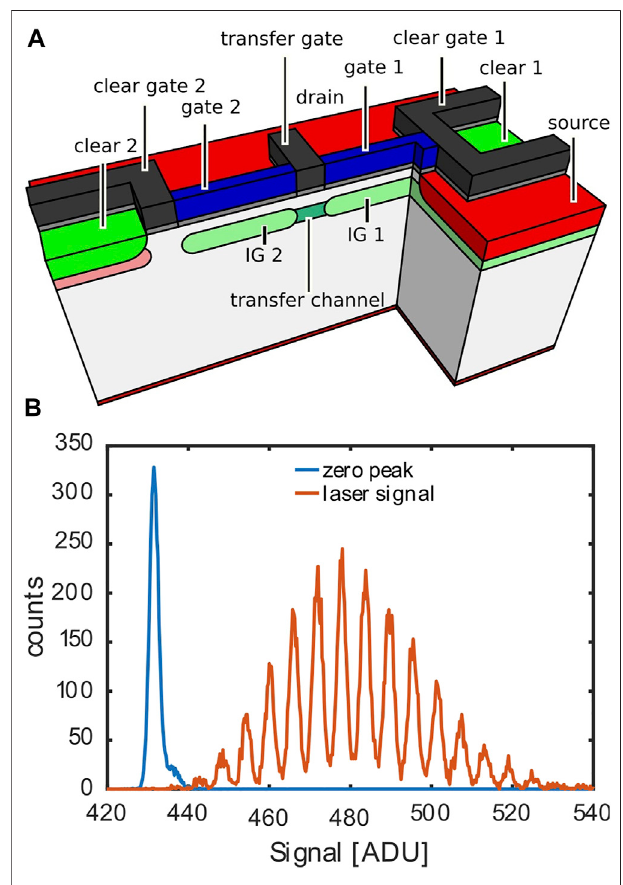
FIGURE 7 | (A) shows a sketch of a DePFET with Repetitive Non- Destructive Readout functionality (B) Shows a histogram of an RNDR DePFET. On the x -axis is the amplitude in arbitrary digital unis and the counts perchannelonthe y axis.Thebaselinelevelisshowninblue,thesignalof a weak laser source in orange. Due to the low noise of the device achieved at 400 readouts, the peaks corresponding to single electrons are visible